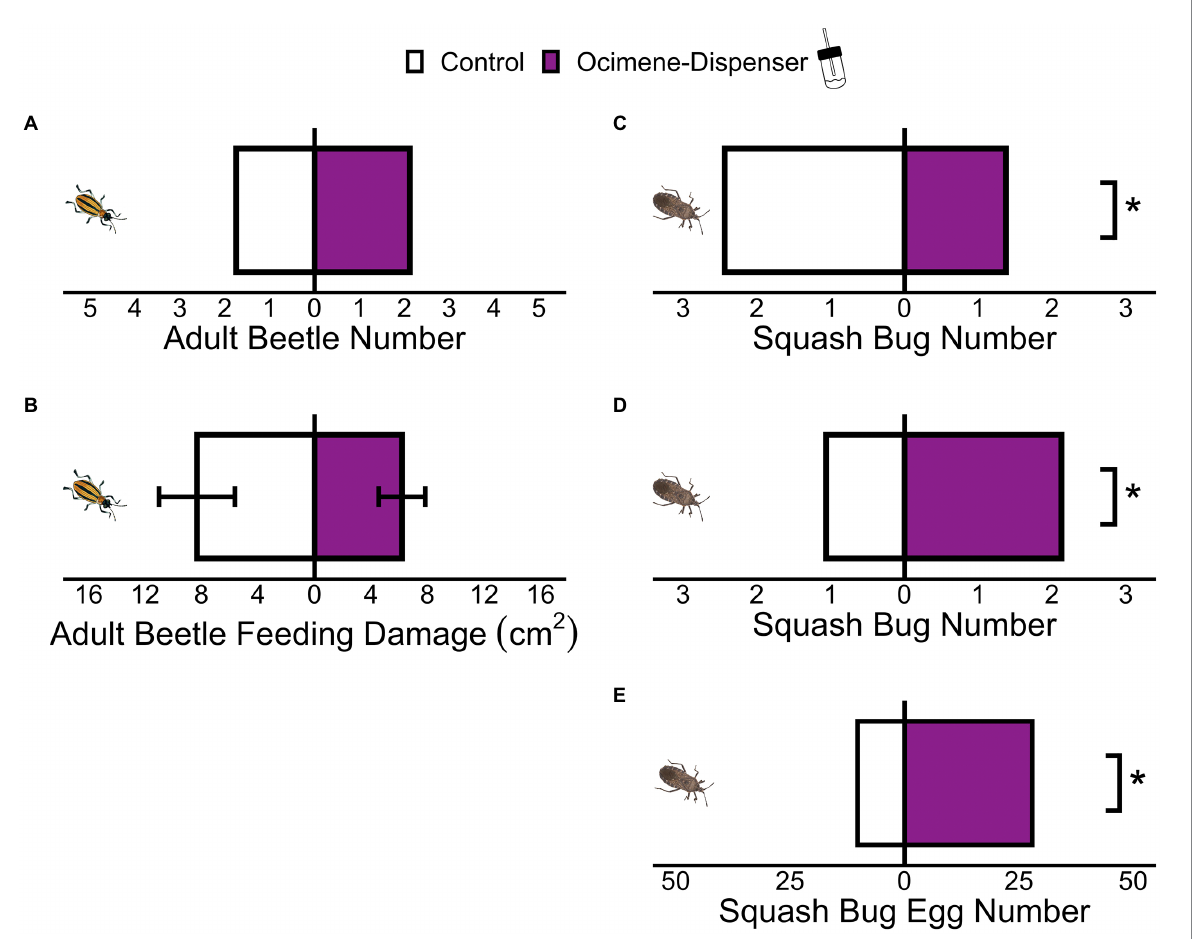
FIGURE 4 Adult beetles (A) settled and (B) fed equally on plants with and without supplemental β -ocimene. (C) Squash bugs avoided plants supplemented with β -ocimene after 48 h of exposure. After 13 days, squash bugs (D) preferred and (E) laid more eggs on plants supplemented with β -ocimene. (* p ≤ 0.05) Means ± SE are